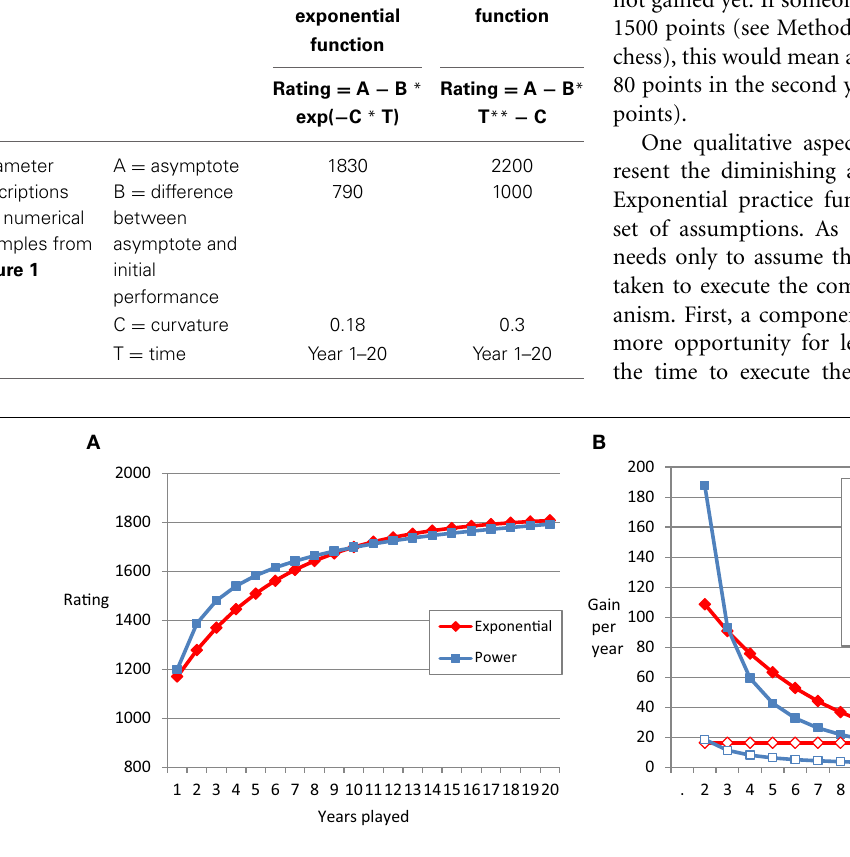
FIGURE 1 | (A) Schematic plot of the power function (blue lines) and negative exponential function (red lines) over 20 time points. (B) Shows the absolute differences in performance from one time point to the next (filled symbols) and the relative learning rate (empty